Question: What visual encoding does this figure use to show its data?
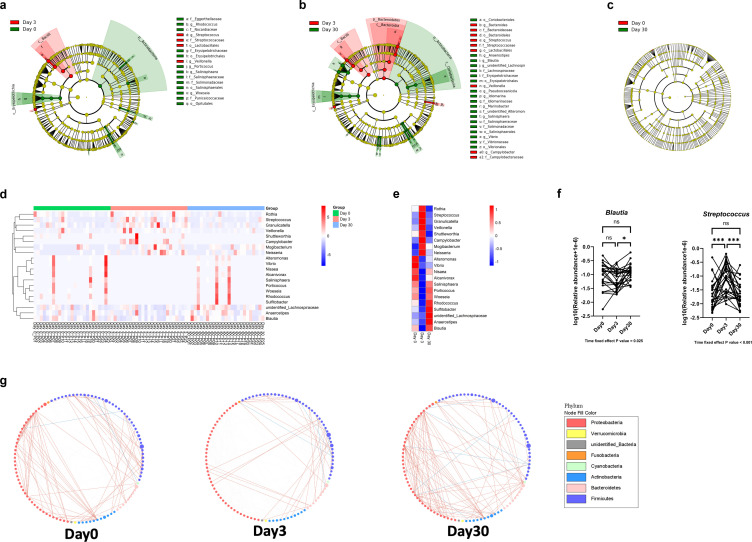
Answer: heatmap